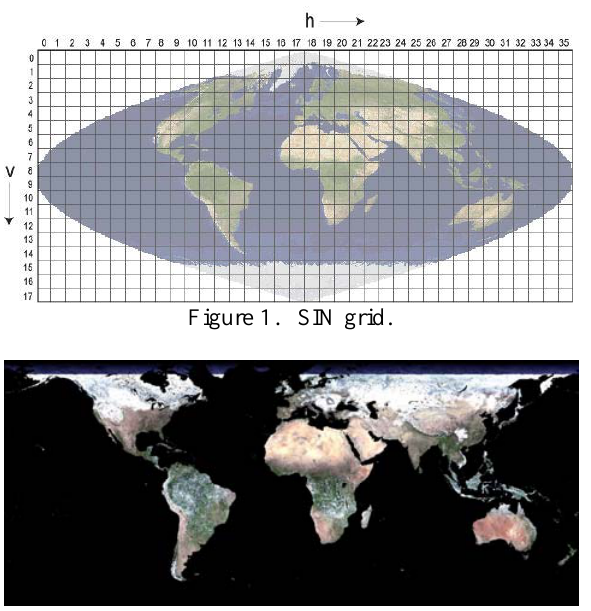
Figure 2. A result of mosaic and geometric transform. ( the scene of